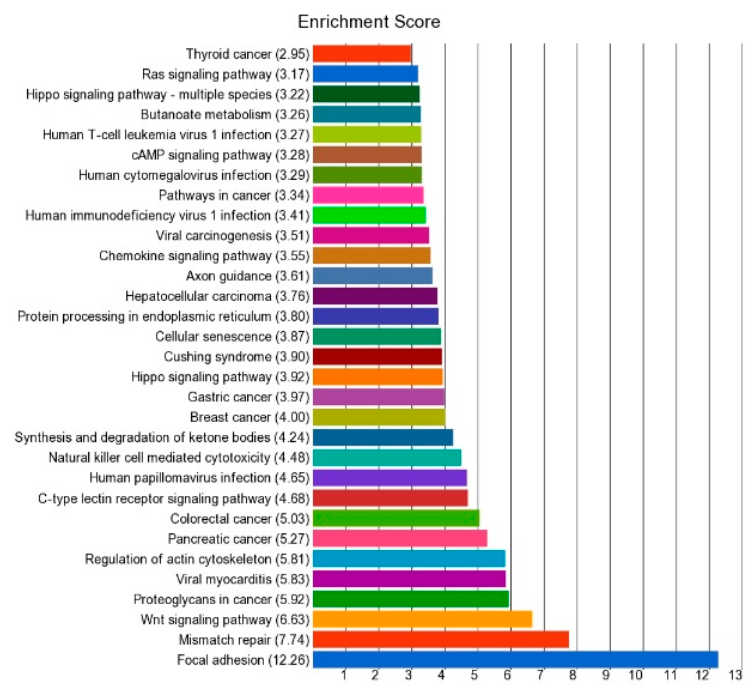
Figure 5. Enrichment score of the 51 common DML in thyroid cancer.